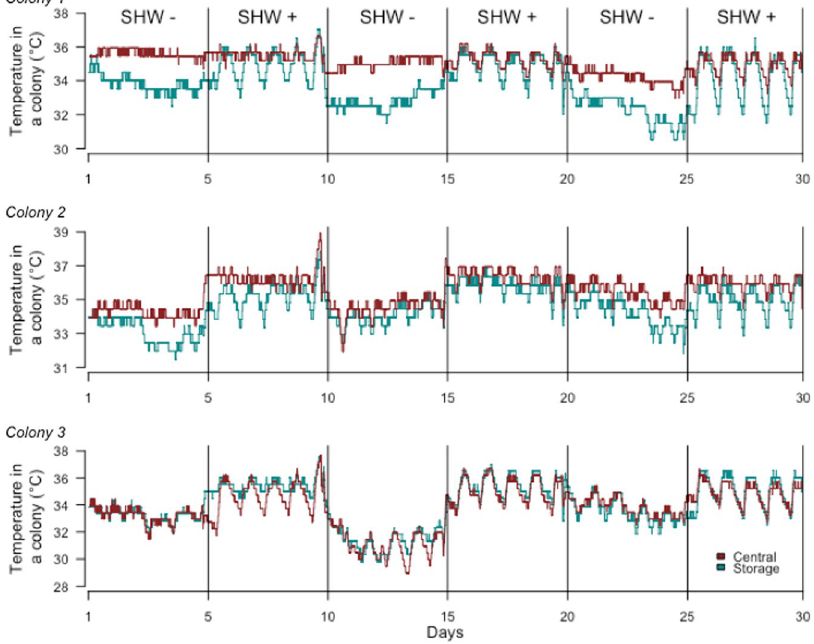
Figure 1. Variations in colony temperature. Temperature recorded on central (red) and storage frames (blue) in each colony. Temperature (°C) was recorded on frames over the successive periods of the SHW treatments by using thermo-tracers. In colony 1, the temperature sensor on the central frame was near the brood. However, in colonies 2 and 3 the brood changed position over time (adult emergence, egg-laying on others frames or away from the temperature sensor), which explains the lack of thermoregulation near the temperature